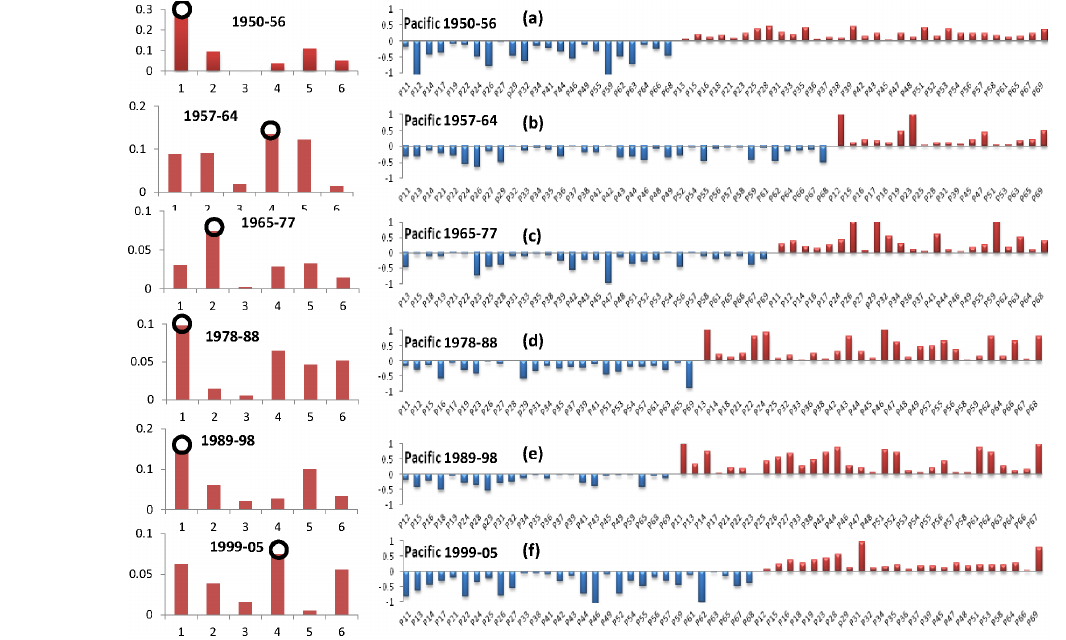
Figure 9. Pacific Ocean. Left panel indicates the wave kinetic energy anomaly 1/2( u 2 (n) + v 2 (n) ) with wavenumber ( x axis). Right panel indicates the average normalized fish landings for the Pacific Ocean for each species in the periods coincident with abrupt climate regime shifts. (a) 1950–1956, (b) 1957–1964, (c) 1965–1977, (d) 1978–1988, (e) 1989–1998, and (f) 1999–2005. The x axis code number indicates both the geographical ocean sub-region (shown in Fig. 1) and the FAO fish species category. The codes are summarized in Table A1 of the